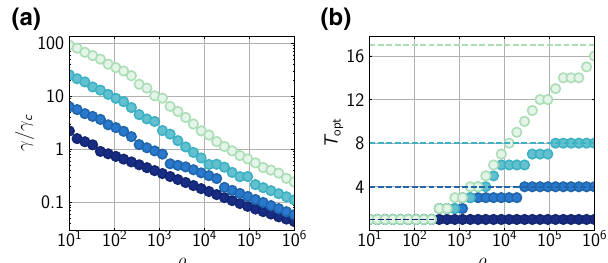
FIG. 12. (a) Ratio of optimal step width γ to critical step width γ ρ for n = k = ( 4, 6, 8, 10 ) c versus the interaction-to-decay ratio denoted by markers shaded from darkest to lightest. (b) Optimal number of Grover iterations T opt versus the interaction-to-decay ratio ρ for n = k = ( 4, 6, 8, 10 ) denoted by markers shaded from darkest to lightest. Dashed lines represent the number of iter- ations T opt at which the speedup is maximized in the ideal Grover’s